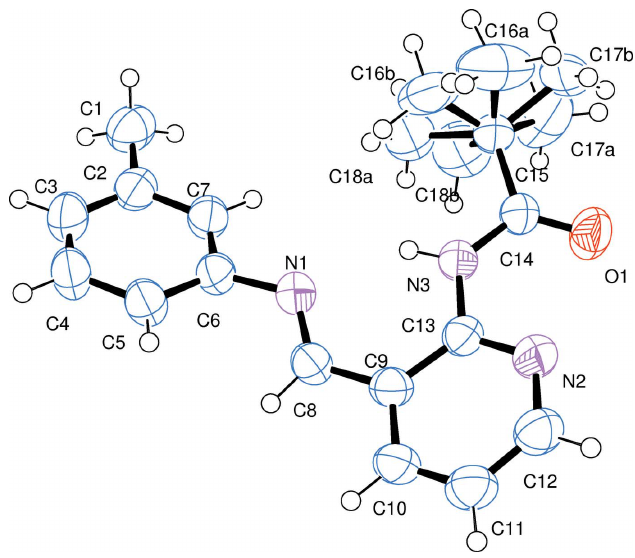
Figure 1 The molecular structure, showing 50% probability displacement ellip- soids. Both orientations of the disordered tert -butyl group are